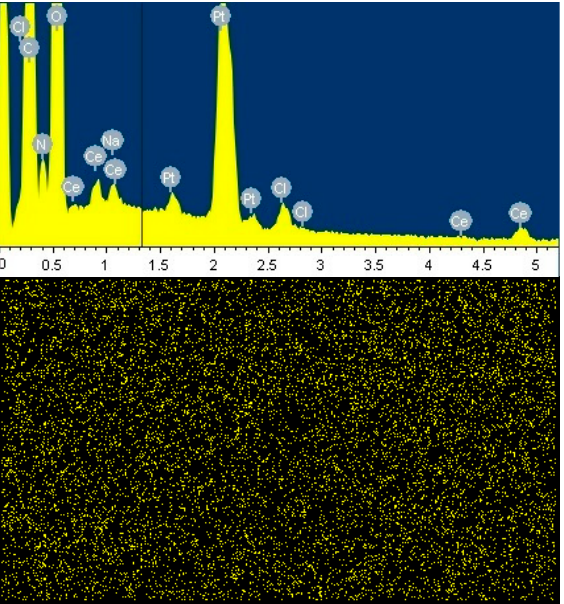
Figure 8. Energy dispersive X-ray spectrum and map of Ce distribution on the surface of a CS(80)- ВС d(20)-CeONP(8) film.